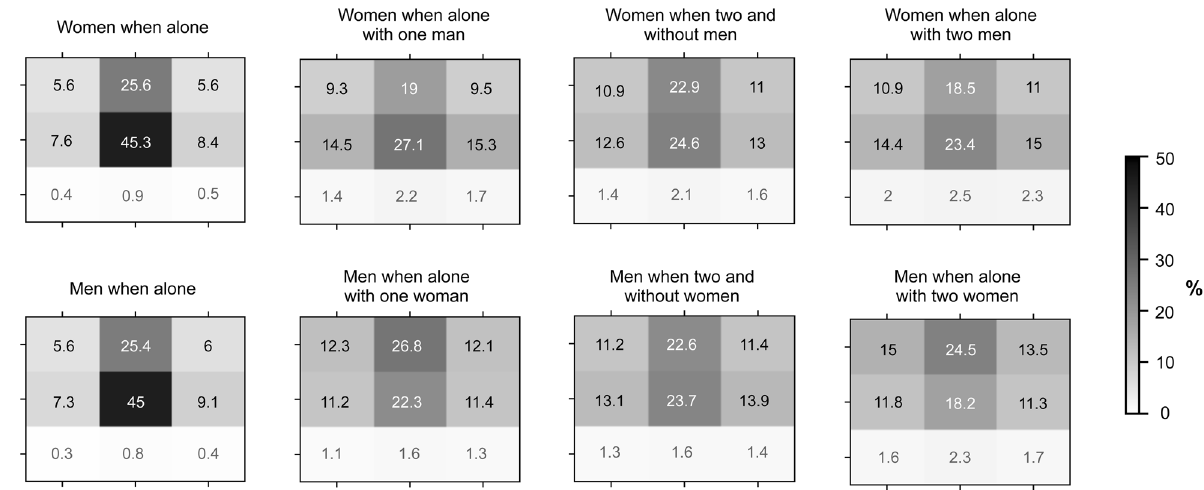
Fig. 6 Distribution of faces position on-screen (2014 – 2019). Each rectangle represents a screen split according to the rule of thirds, where each subsection is annotated with the percentage of faces of the gender mentioned in the each description.